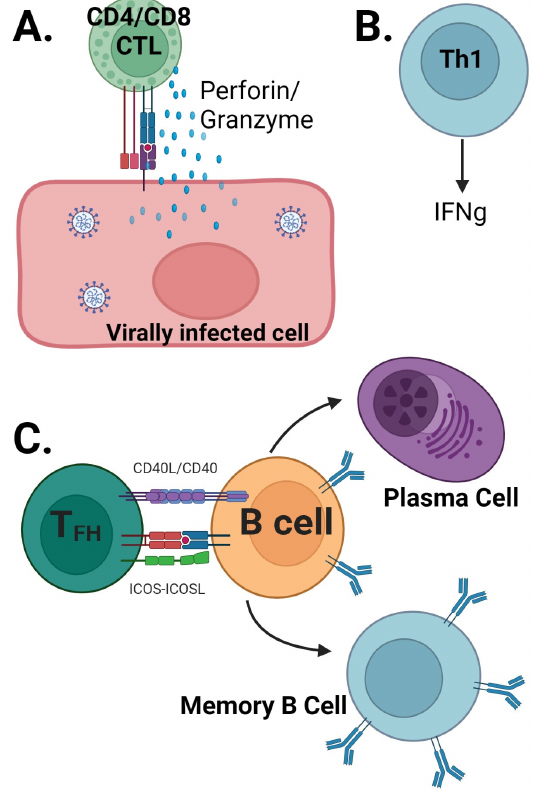
Figure 2. T-cell mechanism of protection against SARS-CoV-2: CD4/CD8 CTL recognize virally infected cells via MHC-peptide TCR interaction, which leads to killing of the virally infected cells ( A ). Th1 cell-secreted cytokines mediate antiviral effect ( B ). T FH cells help in the generation and mainte- nance of antibody response by helping B cells ( C ).